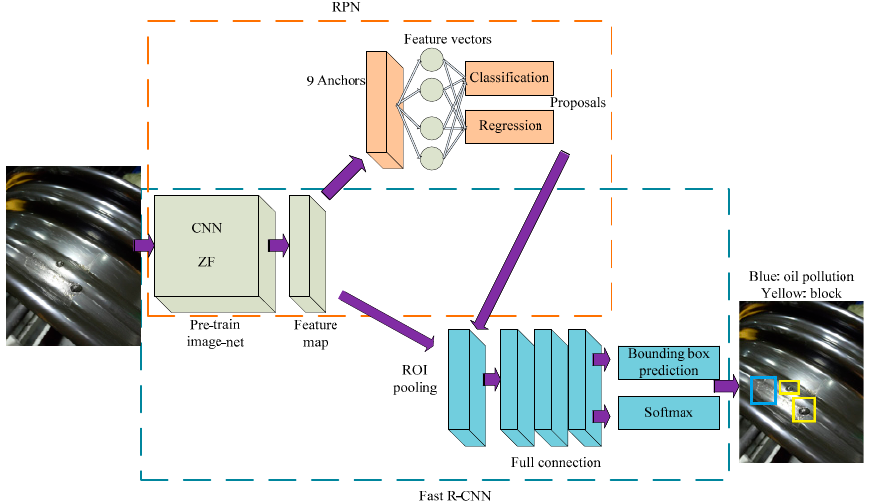
Figure 9. The structure of the improved Faster R-CNN .